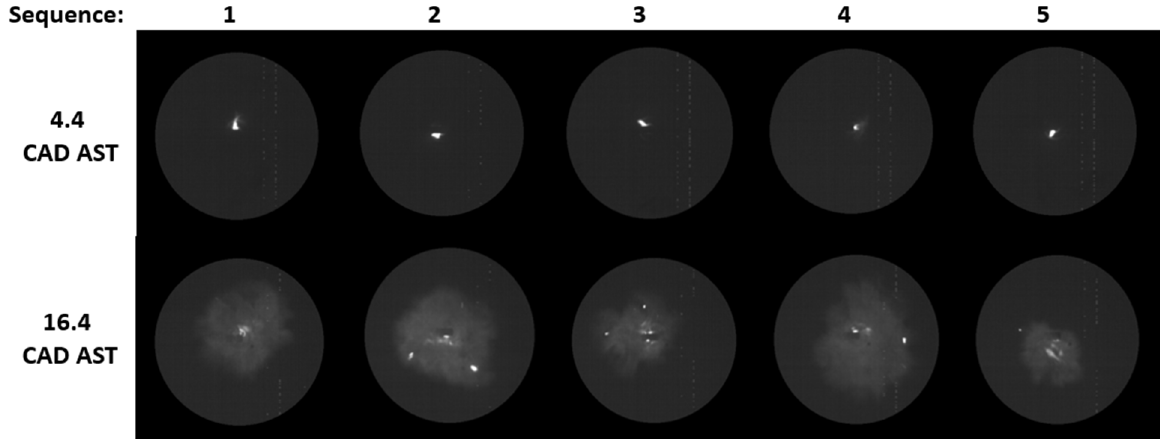
Figure 3. Selected images detected during the kernel phase (4.4 CAD AST) and CA5 (corresponding to 16.4 CAD AST) for the case of a single-electrode design in cross-flow orientation ( λ 1.15, SA 12 CAD).